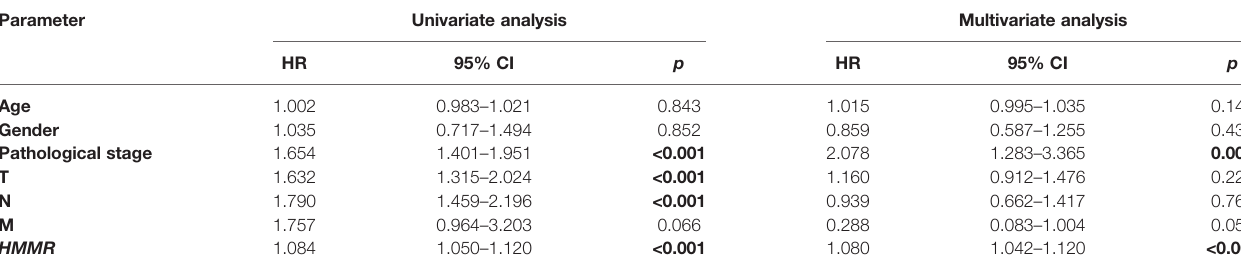
TABLE 5 | Univariate and multivariate analyses of the correlation of HMMR expression with LUAD patients. Parameter Univariate analysis Multivariate analysis HR 95%